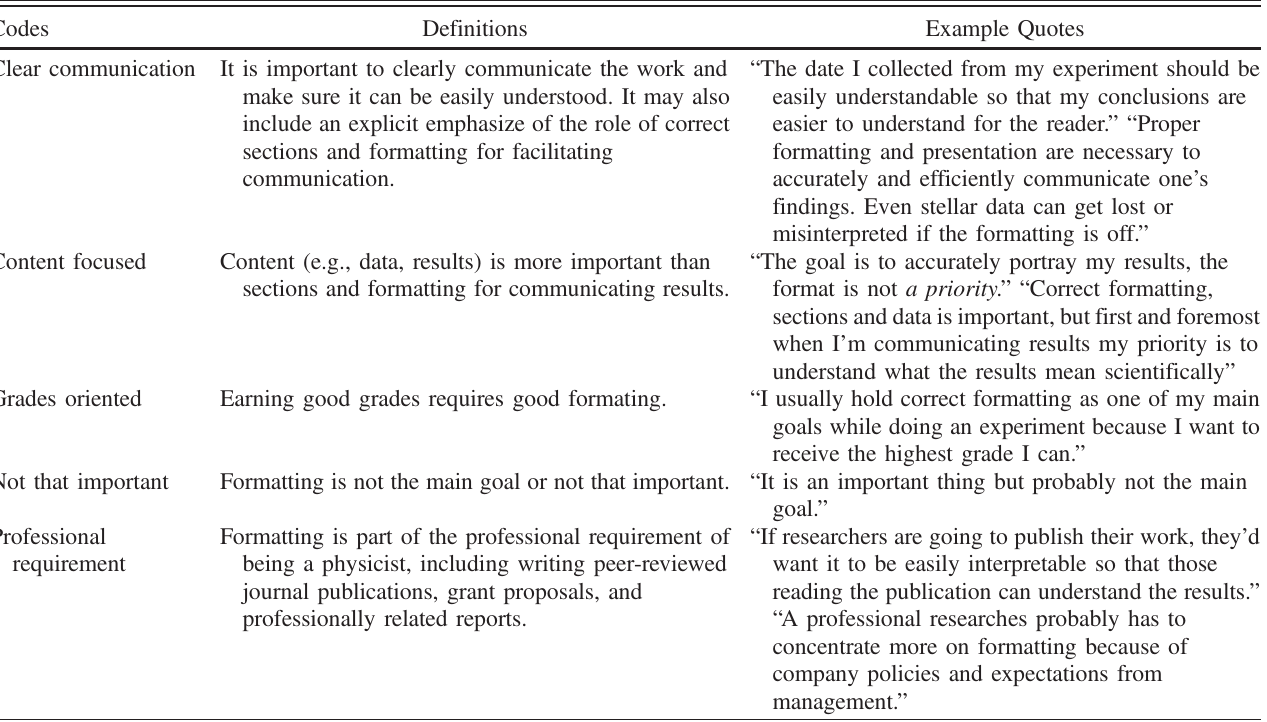
TABLE V. Code definitions and example quotes regarding students ’ responses to Q2a “ When communicating the results from an experiment, my main goal is to have the correct sections and formatting ” and Q2b “ When communicating the results from an experiment, my main goal is to make conclusions based on data using scientific reasoning. ”